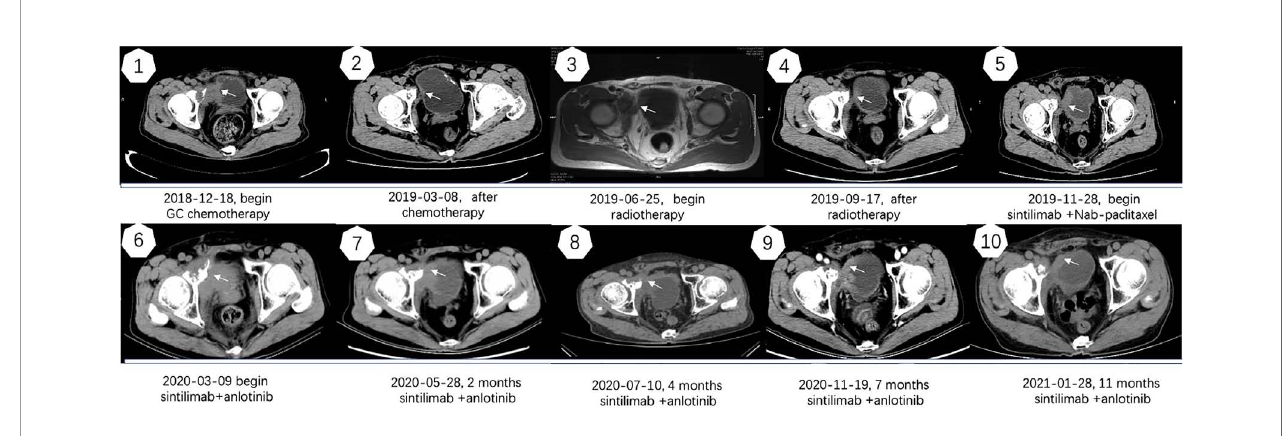
FIGURE 2 | Imaging manifestations of